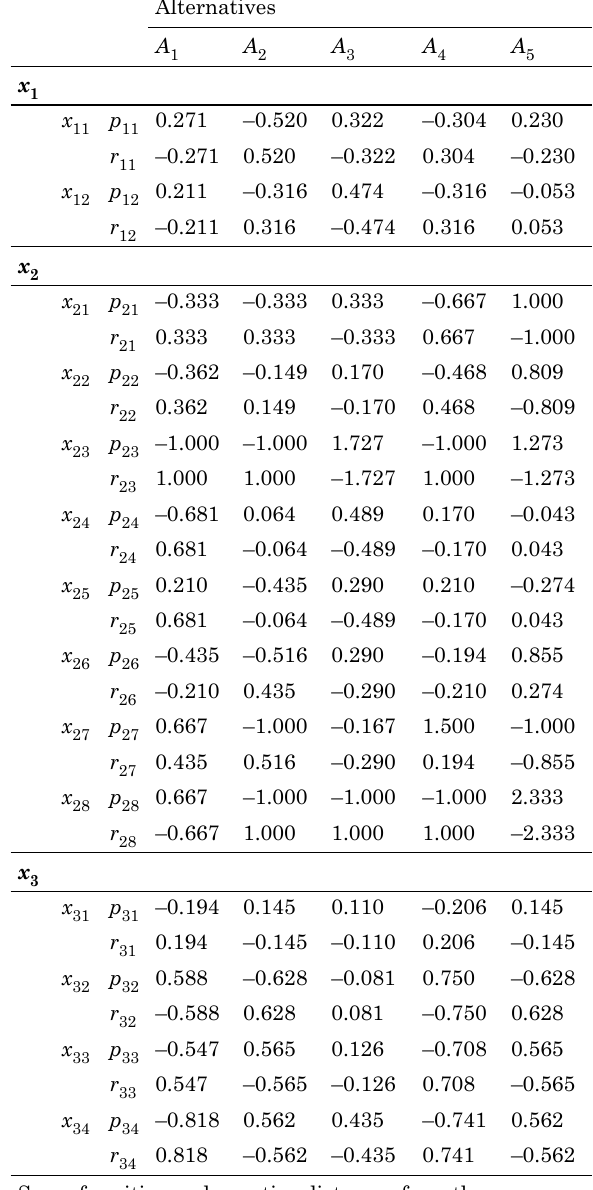
Table 4. Matrix D of positive and negative distances